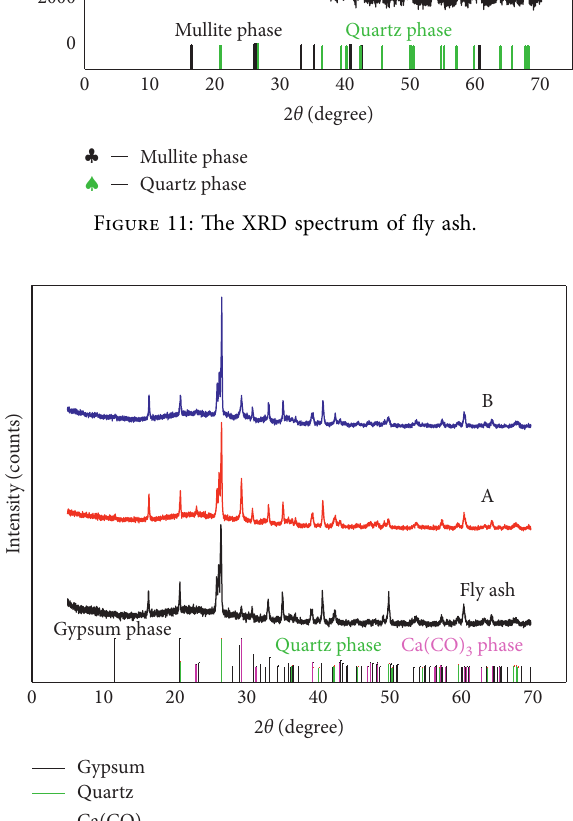
Figure 12: The XRD spectrums of test samples.